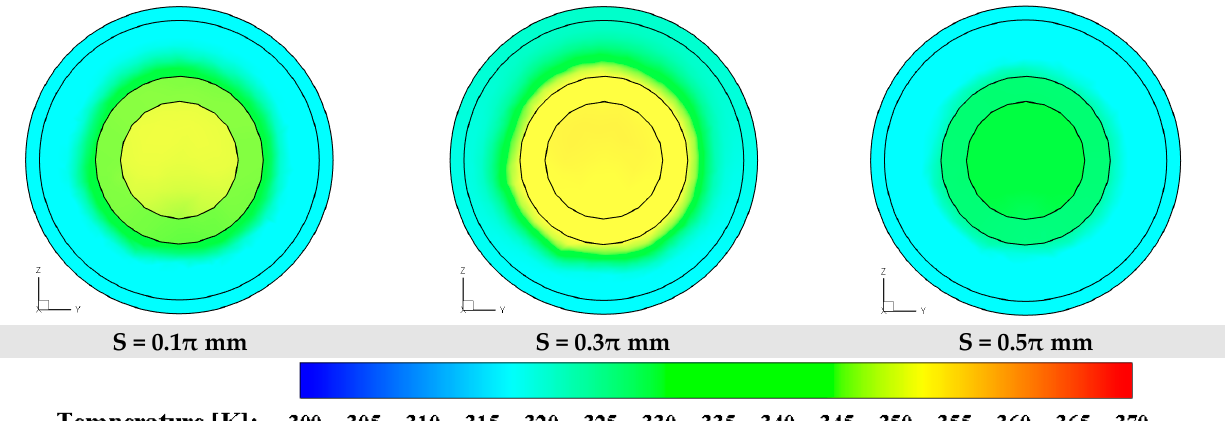
Figure 15. The contours of temperature at exits for different position of proposed swirl generator at θ = 180 degrees, n = 12, R 0 =19 mm, r = 8.4 mm, L 1 = 100 mm, and m (cid:4662) = 0.043